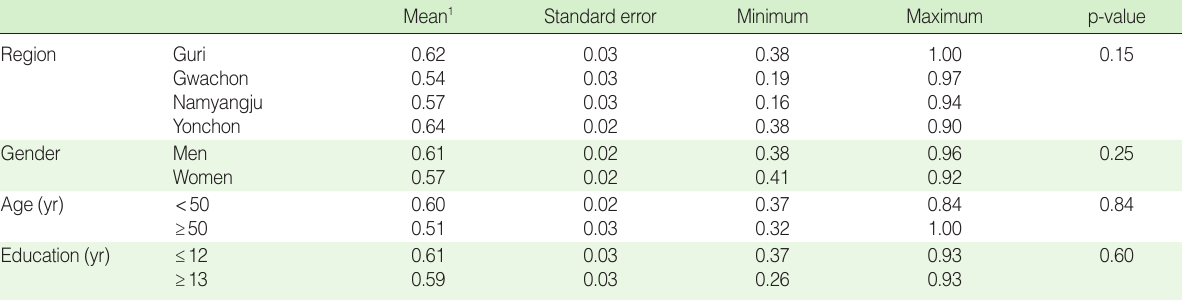
Table 3. Kappa statistics by characteristics of the respondents